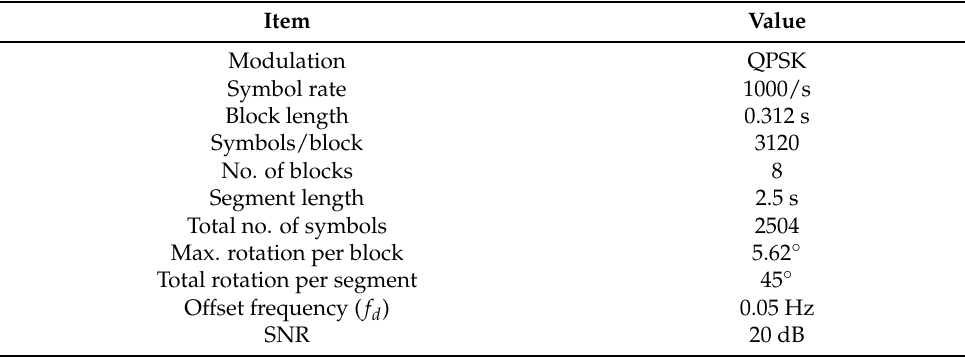
Table 1. Simulated data used for carrier recovery.